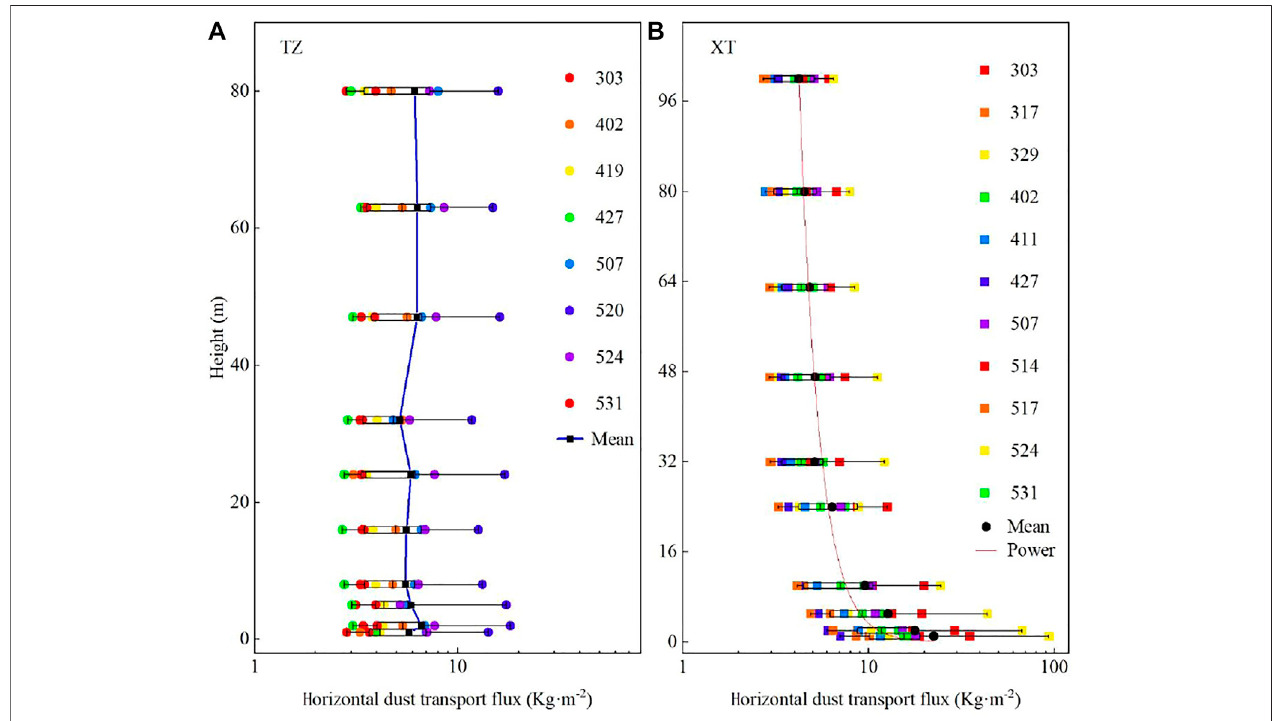
FIGURE 3 | Horizontal dust fl uxes varying with height in (A) XT and (B) TZ (The legends indicate the dates of the dust storms).